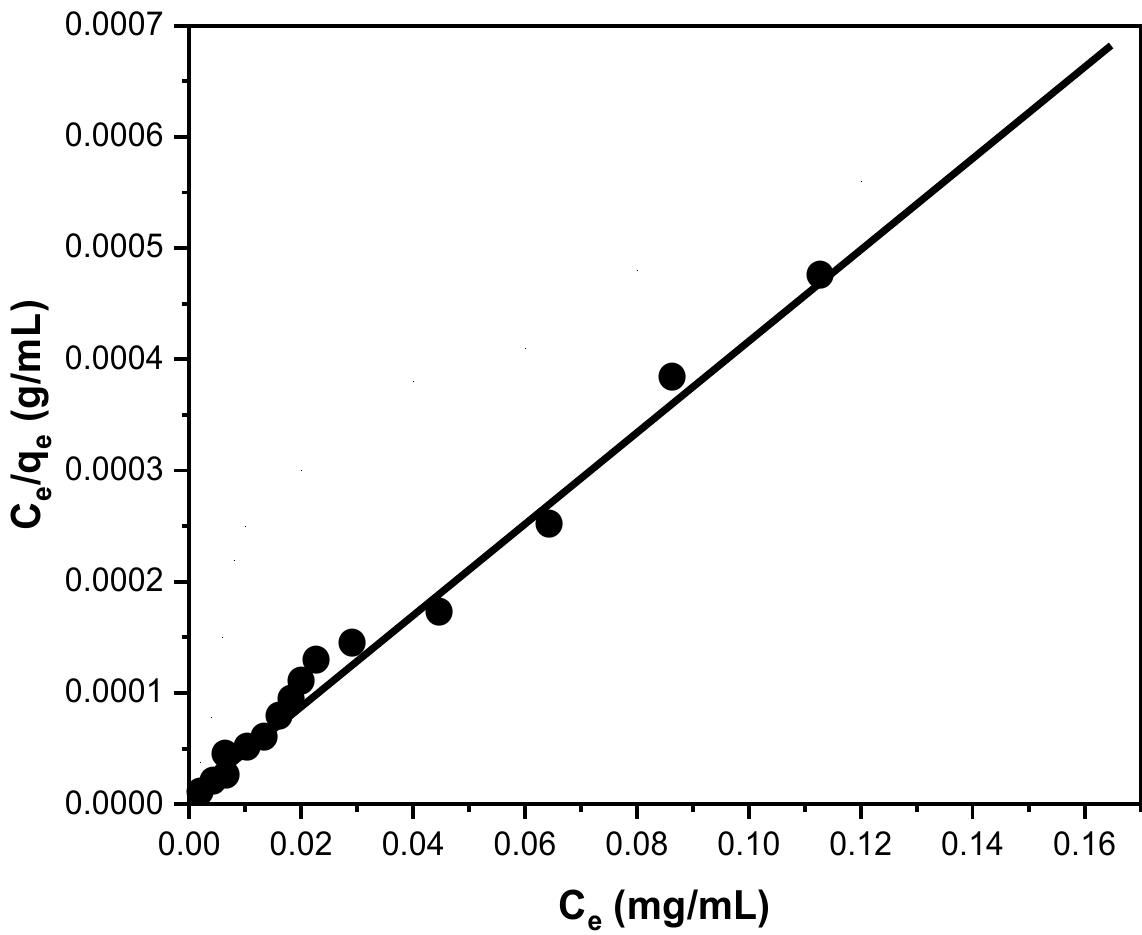
Figure 10. Isotherm model adsorption for Co(II) ion adsorption on 30 mg of A-SPES at 25 °C and pH 6.0. A variety of concentrations (0–175 mg/L) of Co(II) were used at static operations.